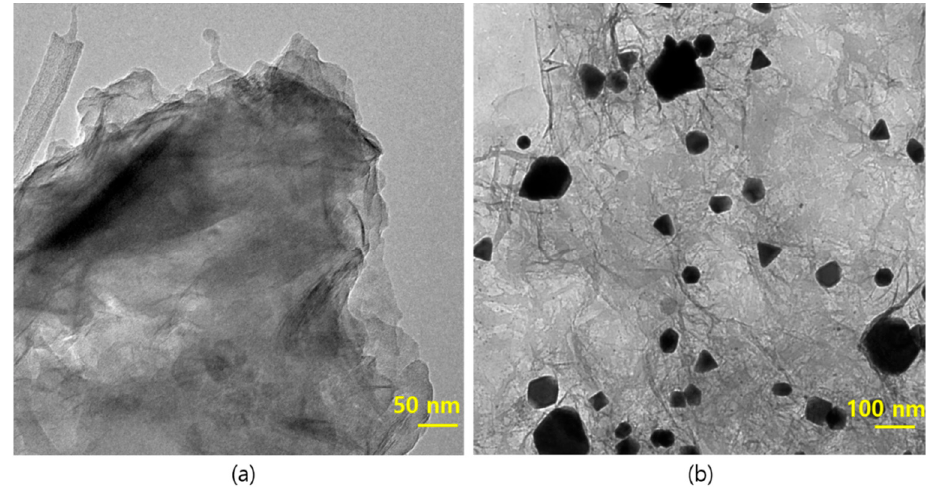
Figure 5. TEM images of Pd/rGO and rGO nanostructures. ( a ) rGO nanosheets, and ( b ) Pd nanostructures anchored on rGO nanosheets.